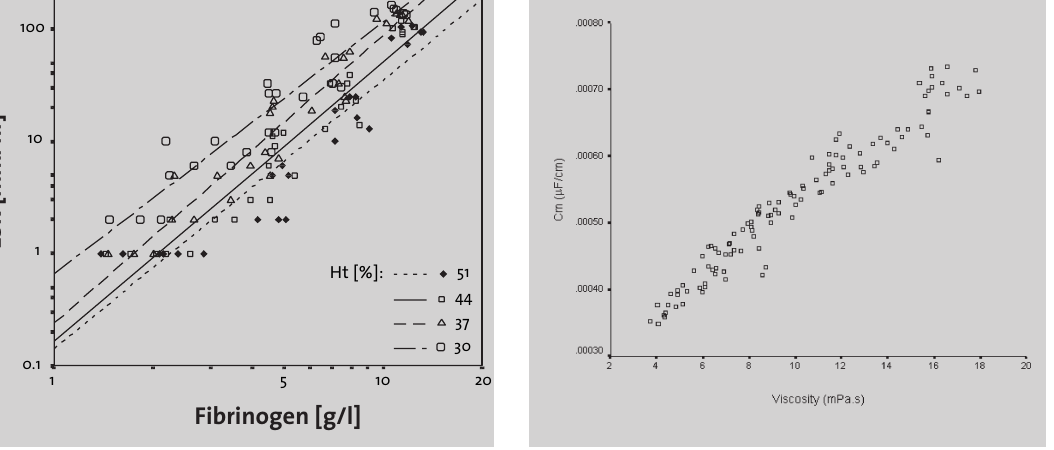
Figure 6 (left): For each different hematocrit a linear relation is obtained between erythrocyte sedimentation rate and fibrinogen. An increase in hematocrit appears to decrease sedimentation rate. Figure 7 (right): Comparison between whole blood viscosity measured at shear rate 4.04 s -1 and the impedance parameter Cm, measured in similar low shear